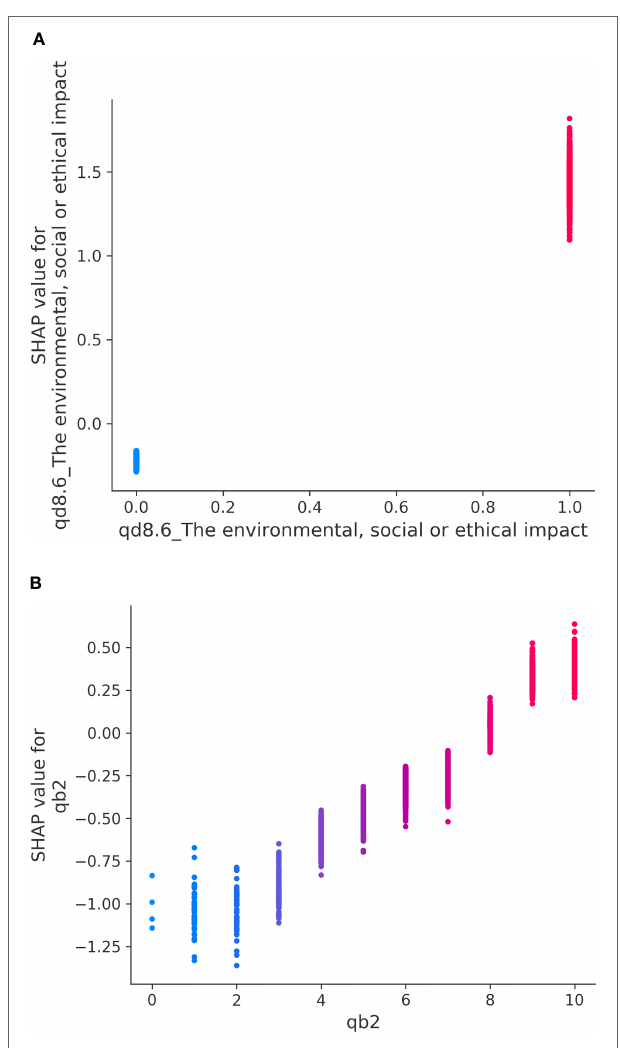
FIGURE 3 | | SHAP feature dependence plot for two variables (A,